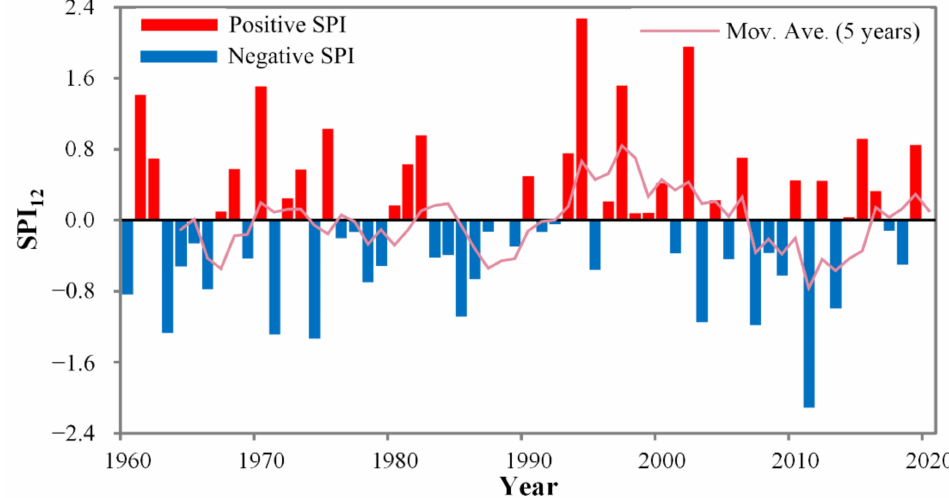
Figure 3. Temporal variation of annual SPI on a 12-month time scale in HSDC,